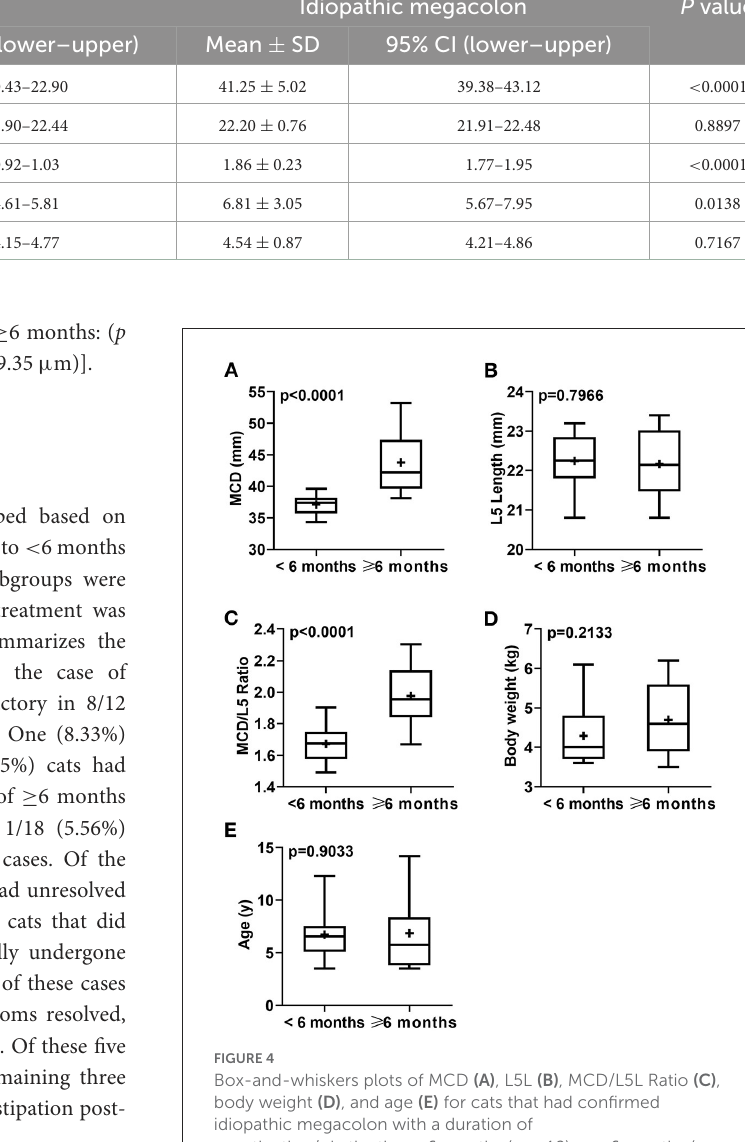
TABLE 2 Descriptive analysis of MCD, L5L, MCD/L5L ratio, age, and body weight for the control cats (30) vs. the case cats (30) with idiopathic megacolon. Variables